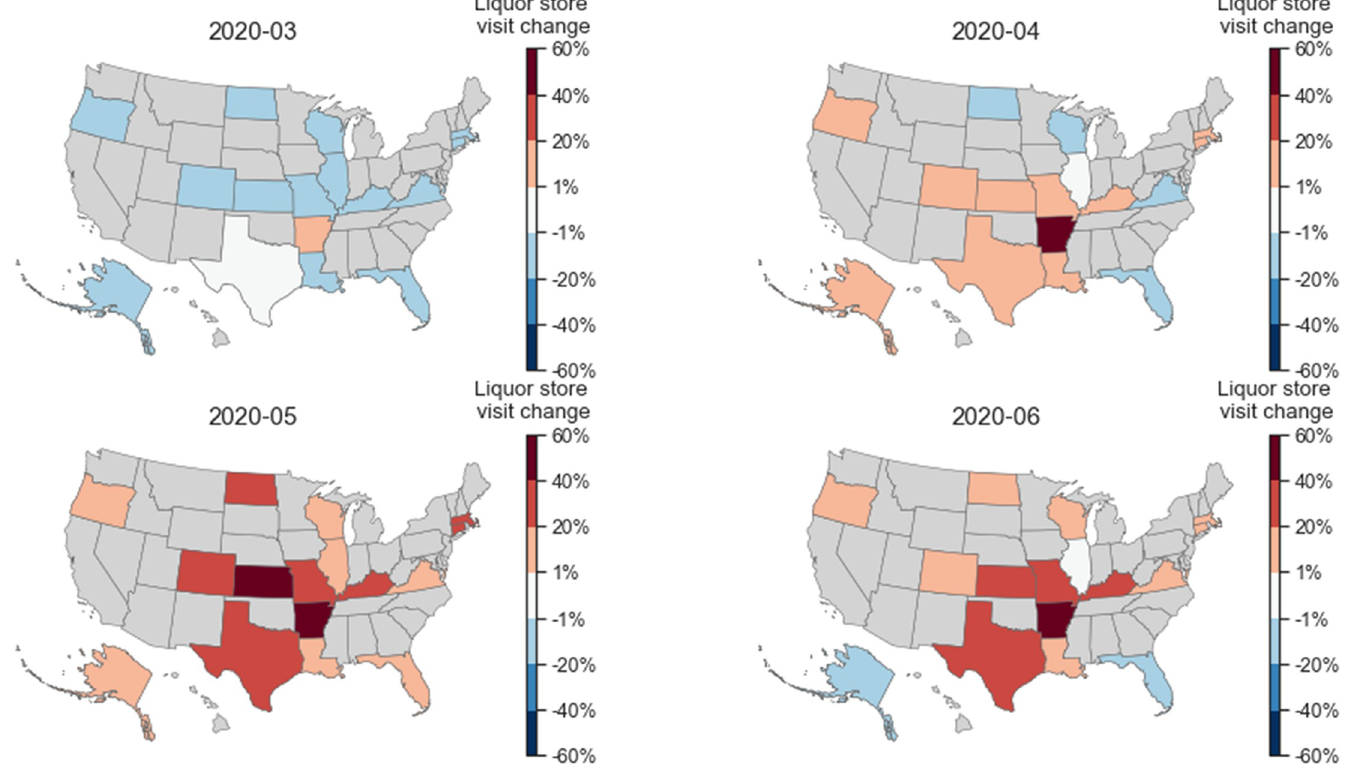
Fig 11. Geographic differences for how the per capita visits to liquor stores changed in response to COVID-19. For each month, the percentage change to visits was computed relative to the average for the same month in 2018 and 2019. Red colors indicate an increase in sales, while blue colors indicate a decrease in sales. The darker the colors, the larger the